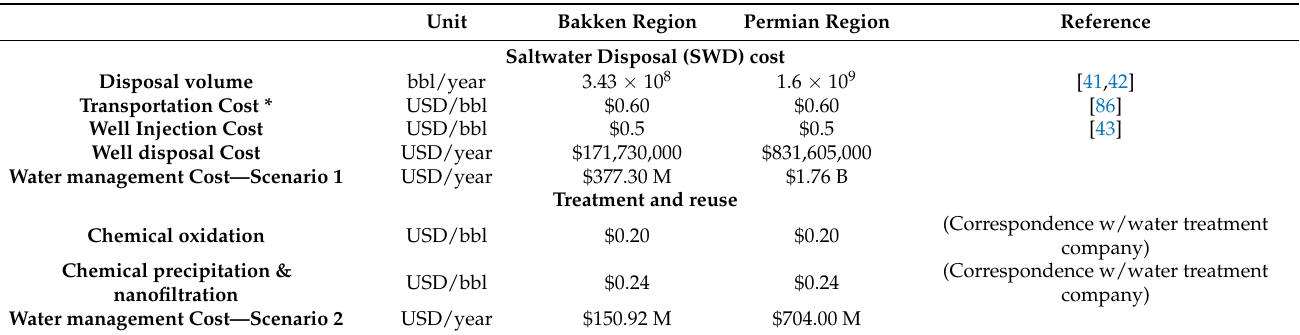
Table 2. Annual cost for disposal and treatment of FP in Permian Basin and Bakken Shale, assuming both are performed on-site. * Based on USD $0.03/bbl/mile trucking cost and an average distance of 20 miles from the source to the nearest disposal